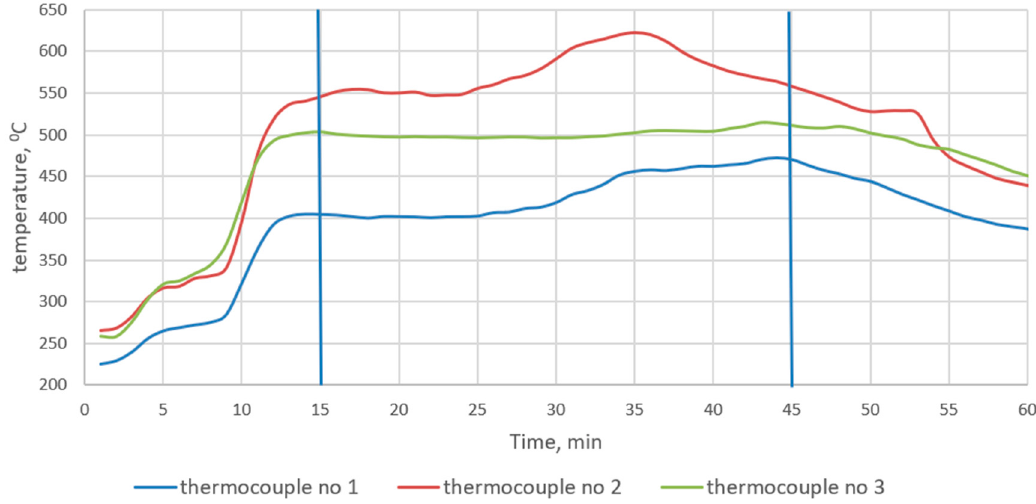
Figure 8. Change in temperature as a function of time for the three thermocouples (1, 2, and 3) shown in Figure 4, which register the exhaust gas temperature flowing around the deflector (Case